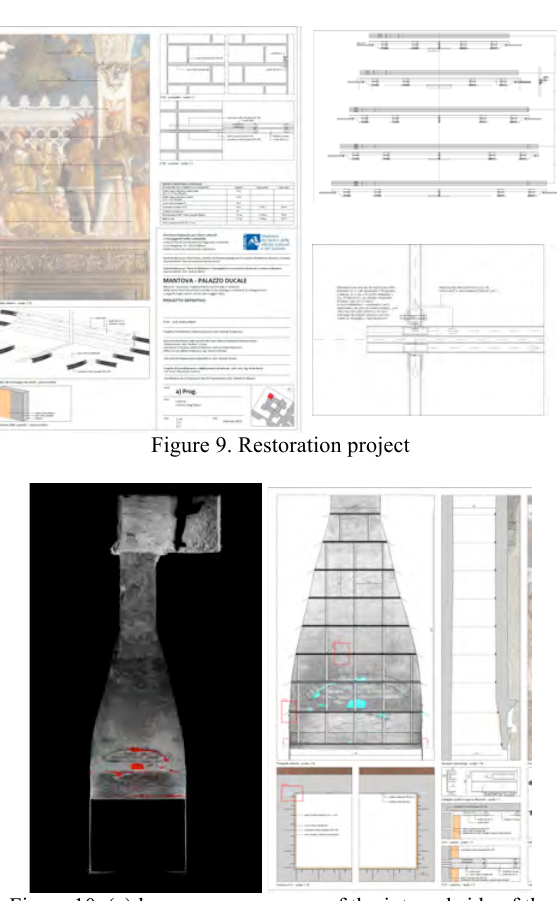
Figure 8. Preliminary results of FE analyses of “della Corte” wall